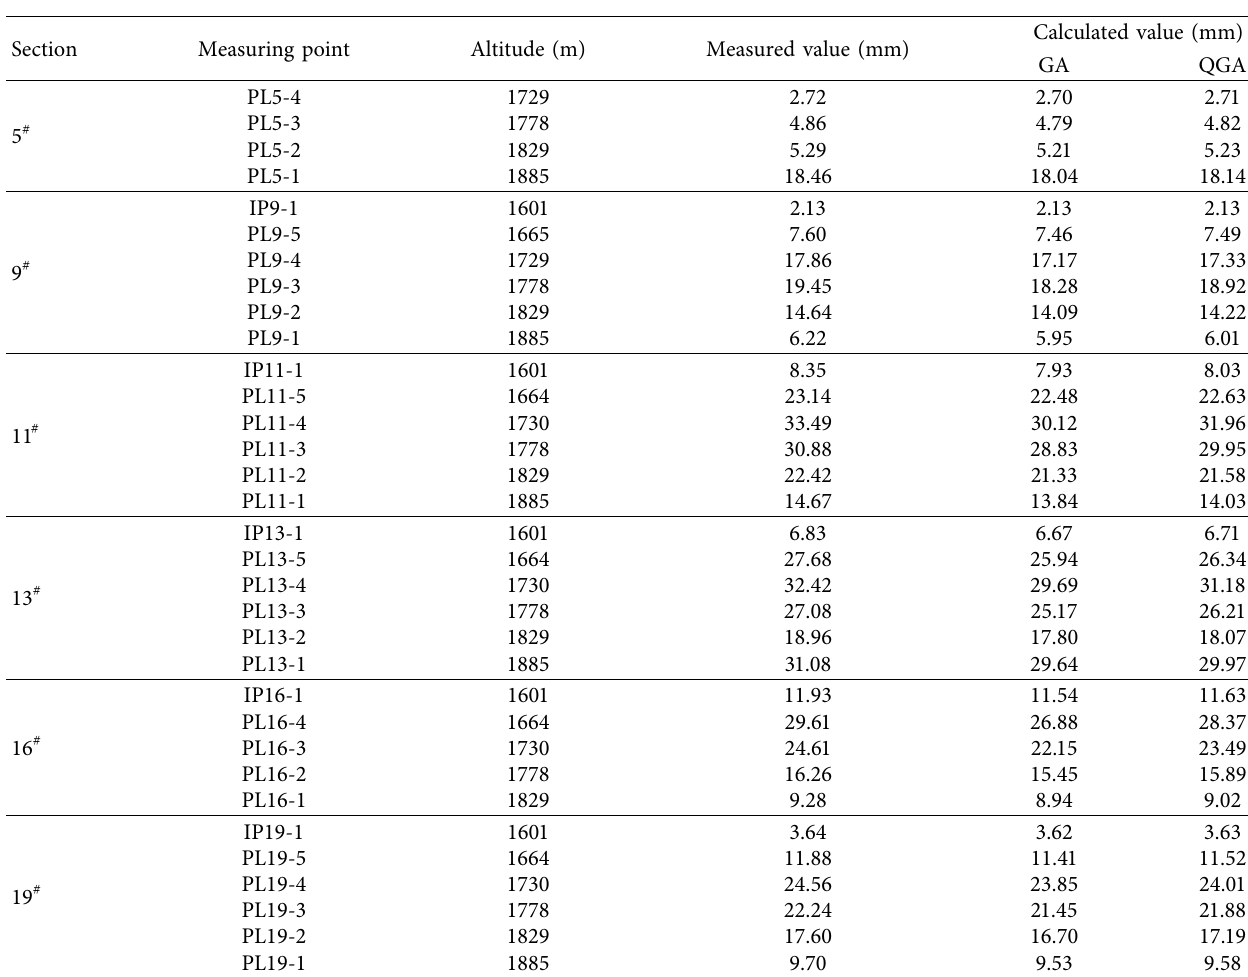
Table 2: Comparison of calculated and measured displacement values of the dam sections’ measure points under the water level of